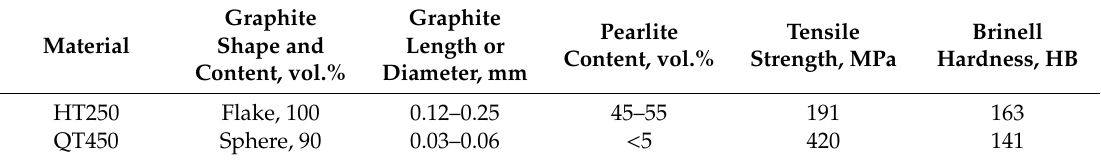
Table 2. The microstructure and mechanical properties of HT250 and